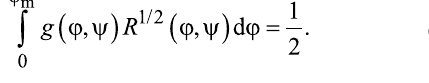
Figure 2. The region under the curve h c ( σ ) corresponds to the planar phase ( n ∥ m ⟂ H ). The region to the left of the curves h r+ ( σ ) and h r − ( σ ) corresponds to the homeotropic phase ( n ⟂ m ∥ H ). The region above the curve h c ( σ ) corresponds to the angular phase with nonuniform directors n and m inside the layer.